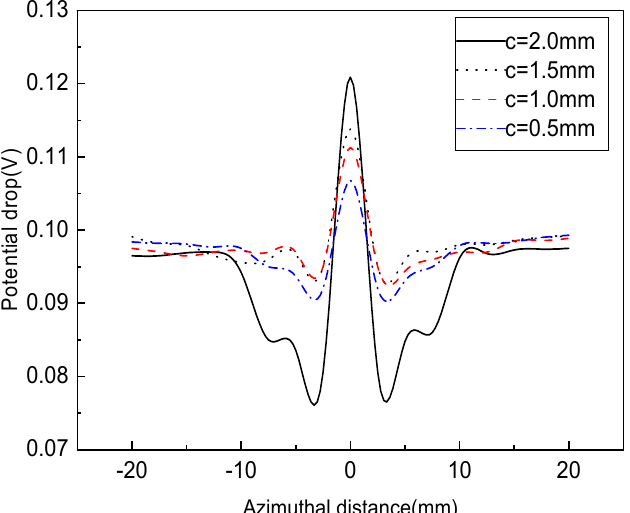
Sensors 2022 , 22 , x FOR PEER REVIEW